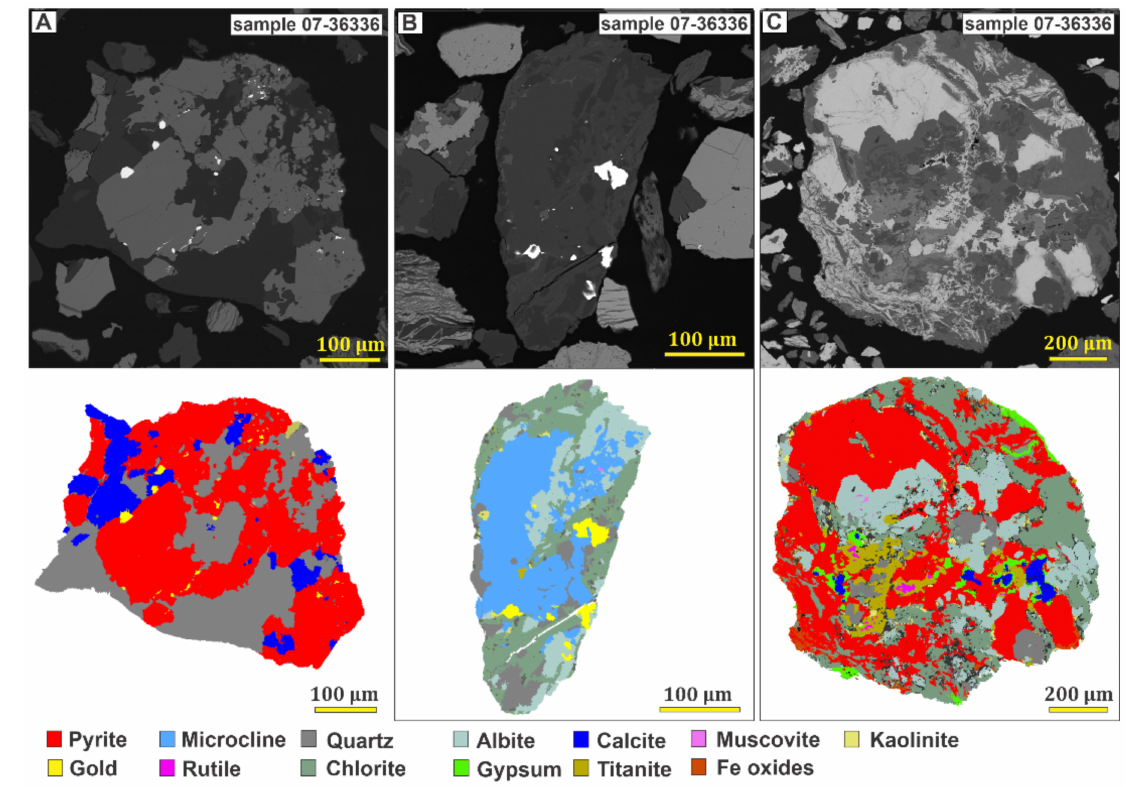
Figure 9. BSE image and the corresponding TIMA mineral maps of gold and pyrite with a hydrothermal mineral association in the mineralization. ( A ) Gold and pyrite are associated with calcite, quartz, and kaolinite. ( B ) Gold is associated with chlorite, albite, microcline, and quartz. ( C ) Pyrite is associated with quartz, albite, chlorite, calcite, muscovite, kaolinite, gypsum, Fe oxides, rutile, and titanite.